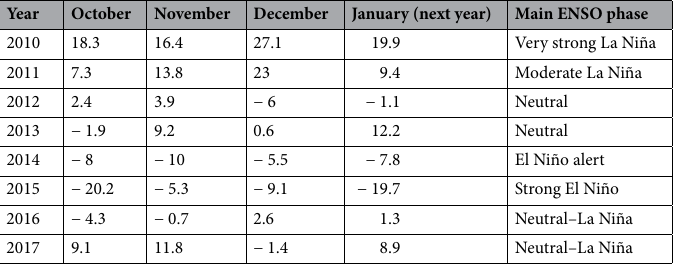
Table 1. The SOI during modelled larval dispersal periods in the GBR. Data obtained from the Australian Bureau of Meteorology (http:// www. bom. gov. au/ clima te/ enso). The main ENSO phases during the 8-year study period are indicated